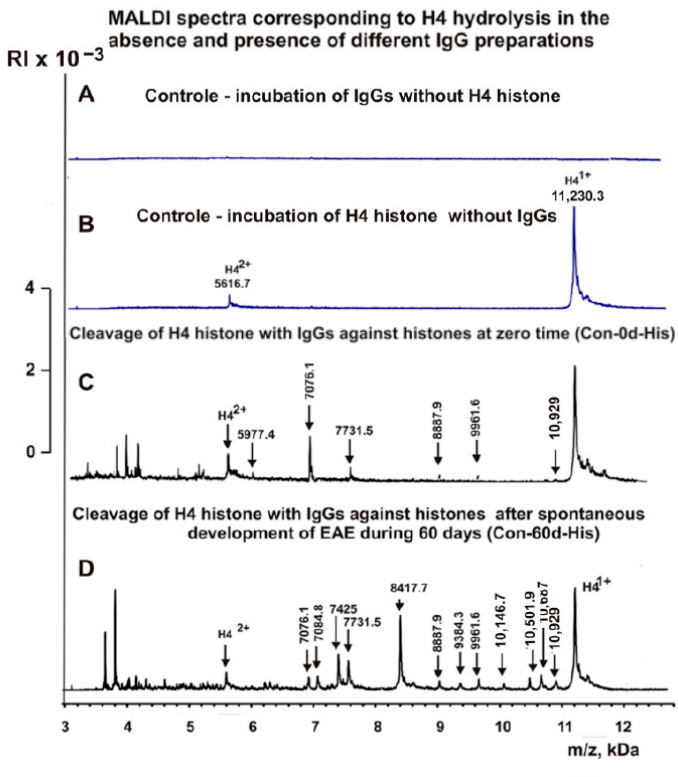
Figure 3. MALDI spectra corresponding to IgGs (0.045 mg/mL) incubated in the absence of H4 histone ( A ), products of H4 histone (0.8 mg/mL) hydrolysis in the absence ( B ) and the presence of IgGs (( C , D ) 0.045 mg/mL) against five histones before immunization with antigens (( C ) zero time—Con-0d-His preparation) and after spontaneous development of EAE during 60 days (Con-60d-His preparation) ( D ).